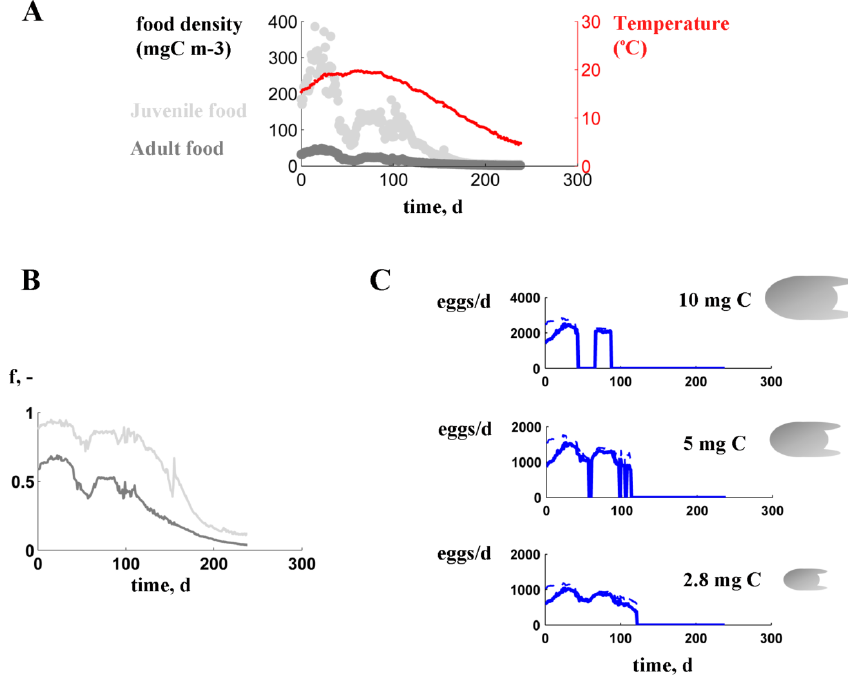
Figure 10. (a) Adult and juvenile food density in combination with temperature experienced by one particle. (b) Scaled functional response f (–) assuming (cid:8) ˙ F m (cid:9) = 4Lday − 1 cm − 2 for juveniles (light grey) and adult (dark grey). (c) We simulate the combined effects of temperature and ingestion level on the daily reproduction rates of a 10, 5 and 2.8mgC individual. The dashed lines assume a constant temperature of 20 ◦ C. For each size class there is a minimum ingestion level for which maintenance can no longer be paid. We assumed that there was no reproduction when f decreased underneath that minimum; see